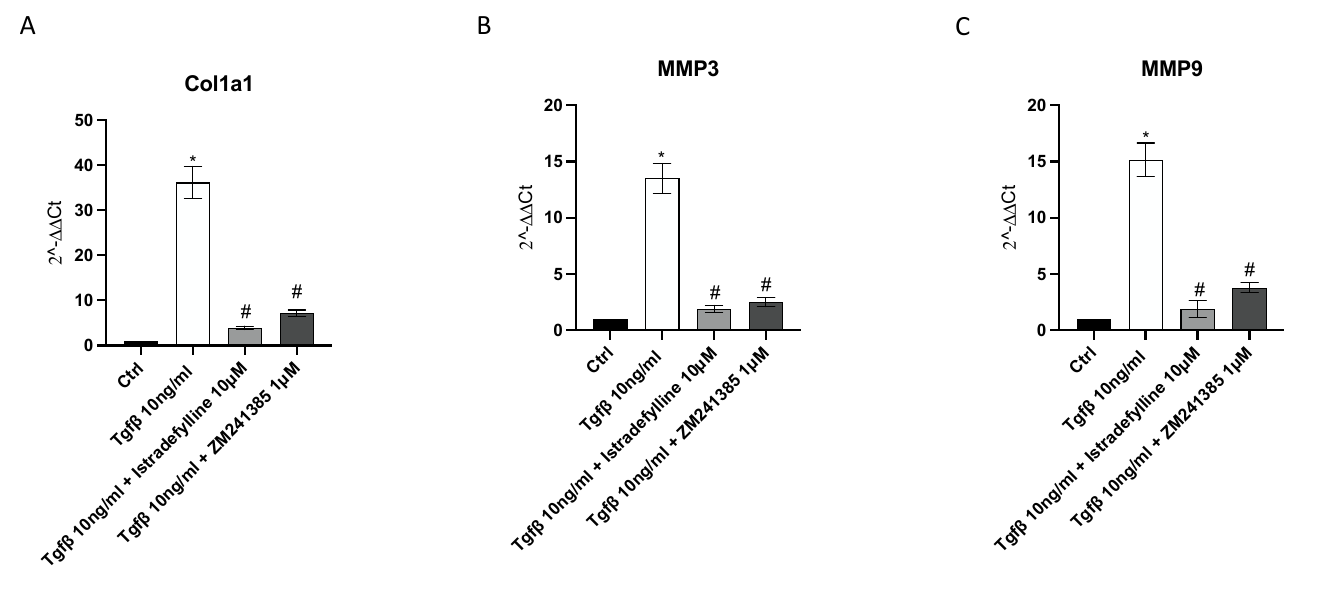
Figure 3. Graphs representing Col1a1 ( A ), MMP3 ( B ) and MMP9 ( C ) mRNA expression assessed via RT-PCR in IM-HCF cells. The data are expressed as the means and SDs of five experiments. * p < 0.05 vs. CTRL; # p < 0.05 vs. TGF- β .